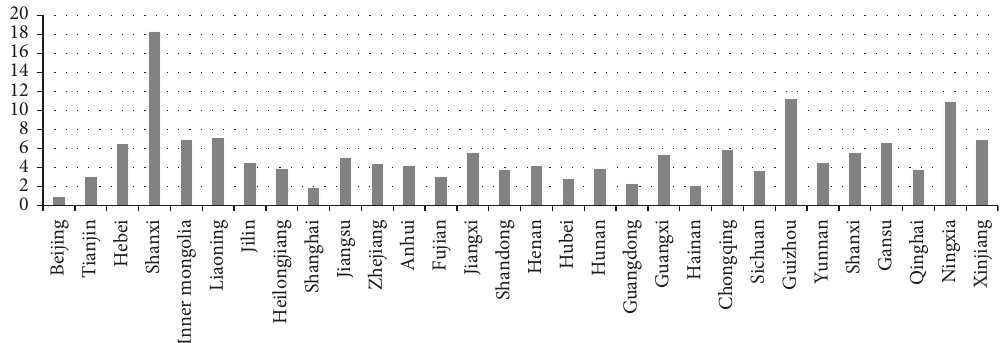
Figure 3: The average value of market incentive environmental regulation (2006–2016).